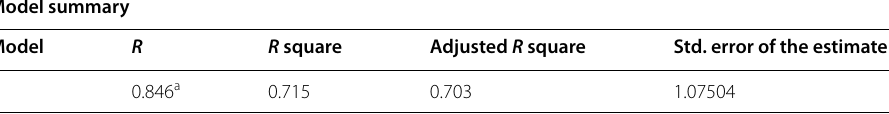
a Predictors: (constant), LnGNI per capita, voice and accountability, political stability, corruption control, regulatory quality b Dependent variable: LnEntreprenurship